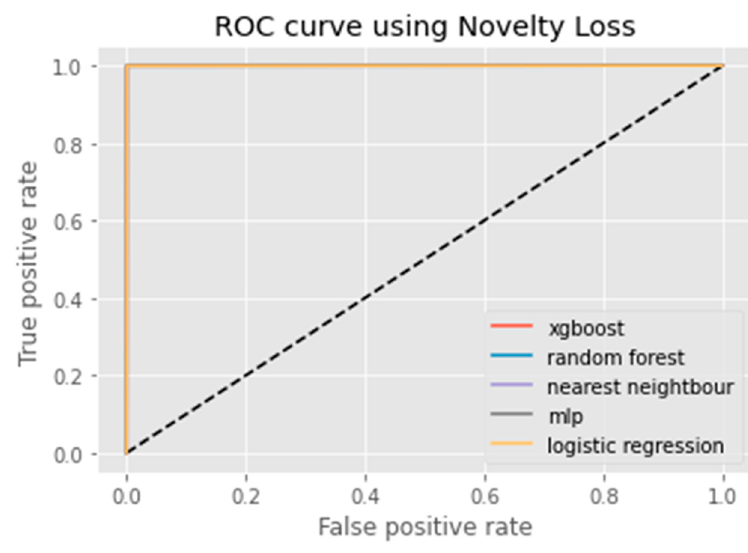
Figure 2. ROC curve of K-CGAN.